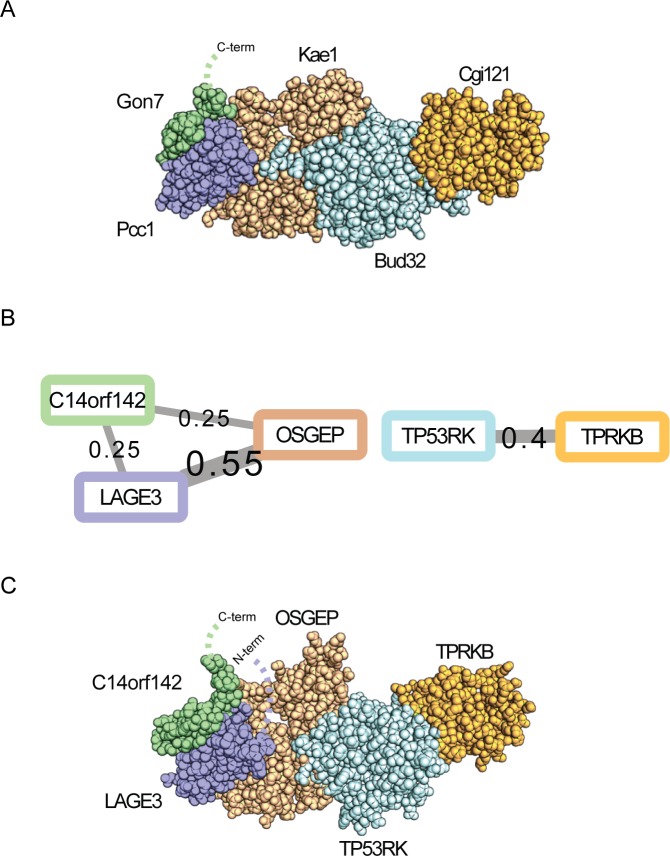
Identification of direct contacts between C14ORF142 and the human EKC/KEOPS tRNA modification complex.A. Highly conserved across both prokaryotes and eukaryotes, the EKC/KEOPS complex is thought to consist of 5 proteins, visualized here for the yeast complex based on a combination of modeling and crystal structures (PDB entries 4WX8, 5JMV, 3EN9 and 4WW5). B. Conditionally dependent interactions among subunits of the human protein complex highlight specific contacts that match closely to those observed between the yeast proteins, and additionally implicate the human protein C14ORF142 as directly bound to OSGEP and LAGE3. C. Using the yeast structure as a homology template, a 3D model was built of the 4 known human subunits and C14ORF142, taking advantage of C14ORF142’s distant similarity to the yeast Gon7 subunit.